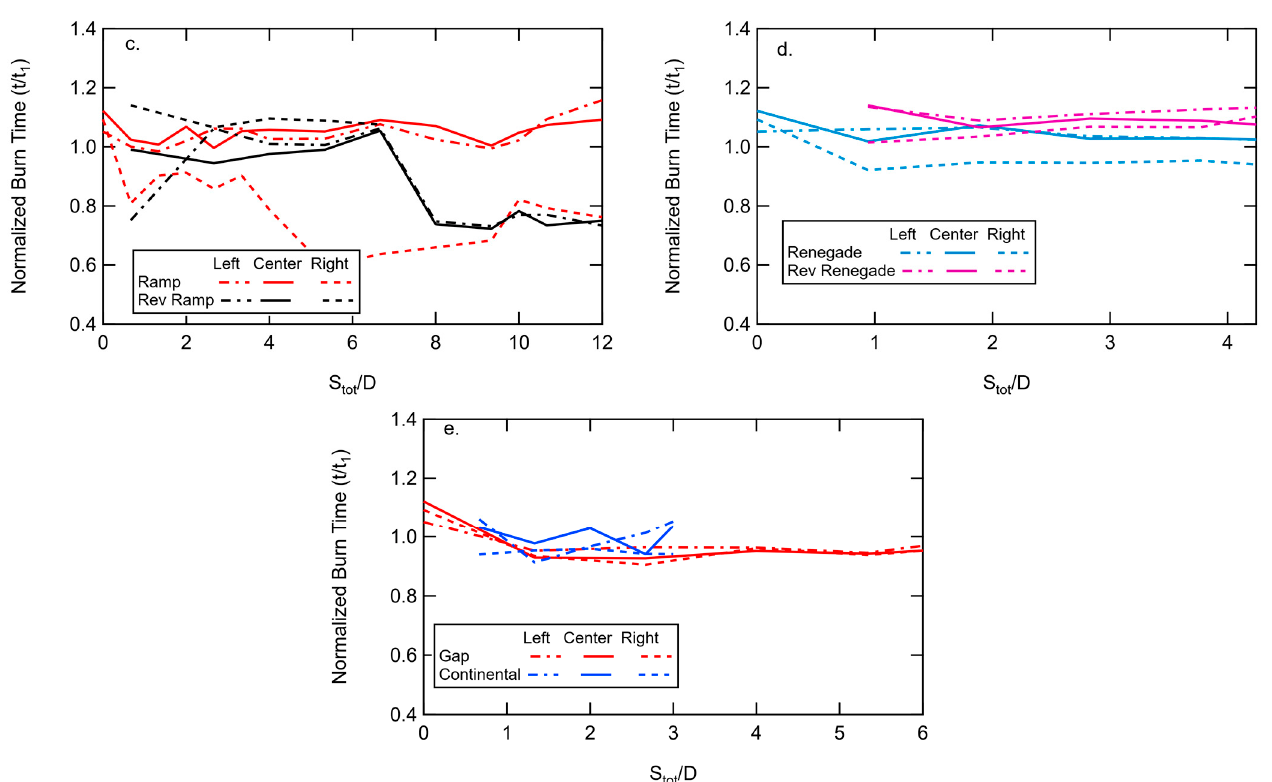
Figure 19. Flame duration times for the three-pad experiments, normalized by the flame duration time for the single-pad experiment ( a – e ). Data were split into subfigures containing only two or three of the configurations shown in Figures 2 and 20. Error bars were omitted for ease of viewing.